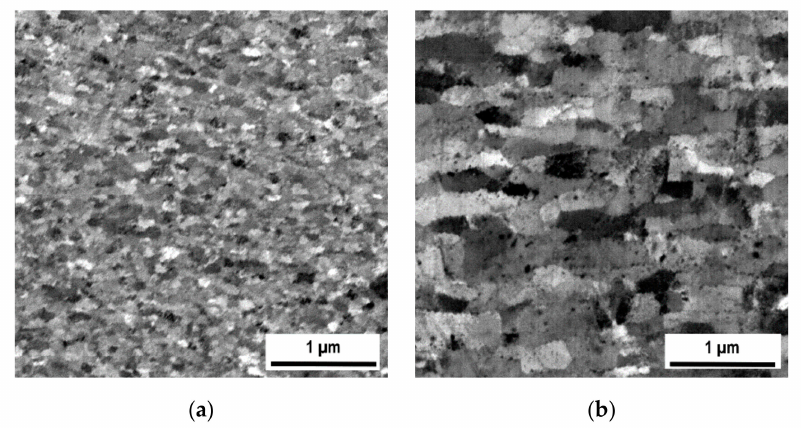
Figure 4. Comparison of microstructures prepared by ( a ) hot rolling in RollDxND plane; ( b ) hot rotary swaging (RS) in SDxRadD